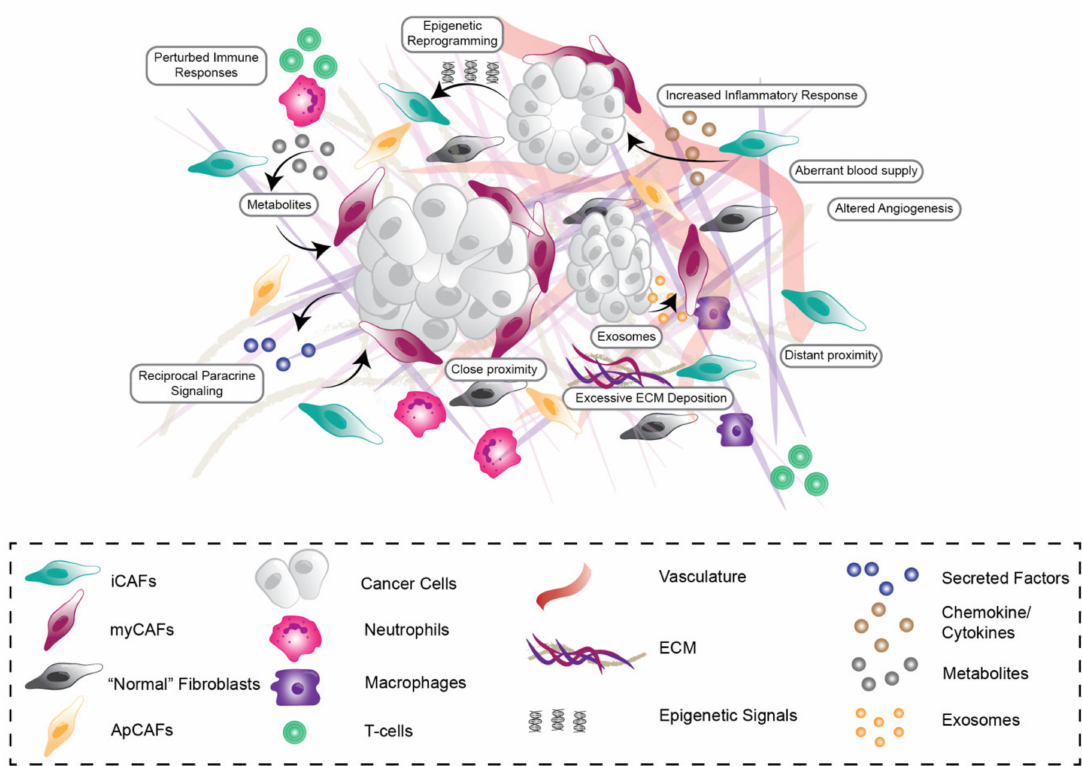
Figure 1. Stromal Heterogeneity in the pancreatic tumor microenvironment. The pancreatic tumor microenvironment is highly heterogenous, consisting of cancer cells, activated cancer-associated fibroblast (CAF) subpopulations, increased depo- sition, remodeling and degradation of extracellular matrix (ECM), aberrant vasculature and impaired immune cell response. CAF subpopulations are influenced by direct-, short- and long-range growth factor (e.g., FGF1), metabolic, chemokine (e.g., CXCL12) and exosome paracrine signalling (indicated by arrows between different cell types and subpopulations) as well as epigenetic regulation via cancer cells, immune cells, vasculature and neighbouring